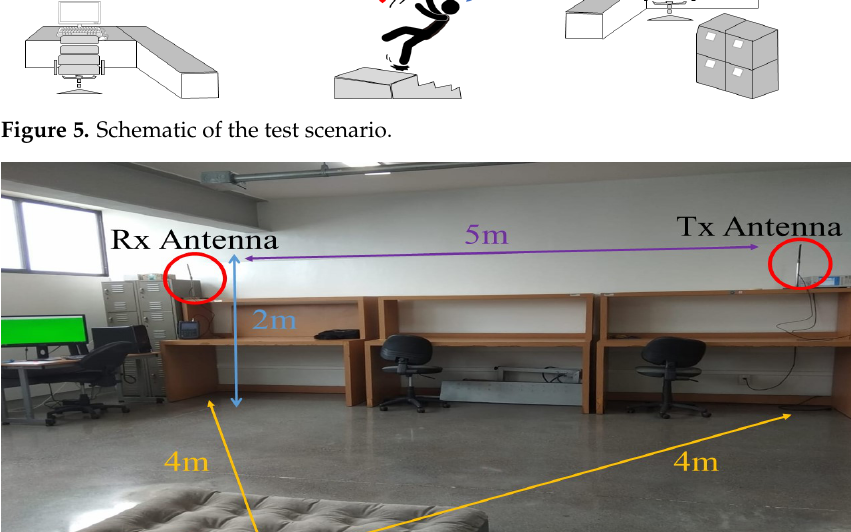
Figure 6. Indoor environment for the test